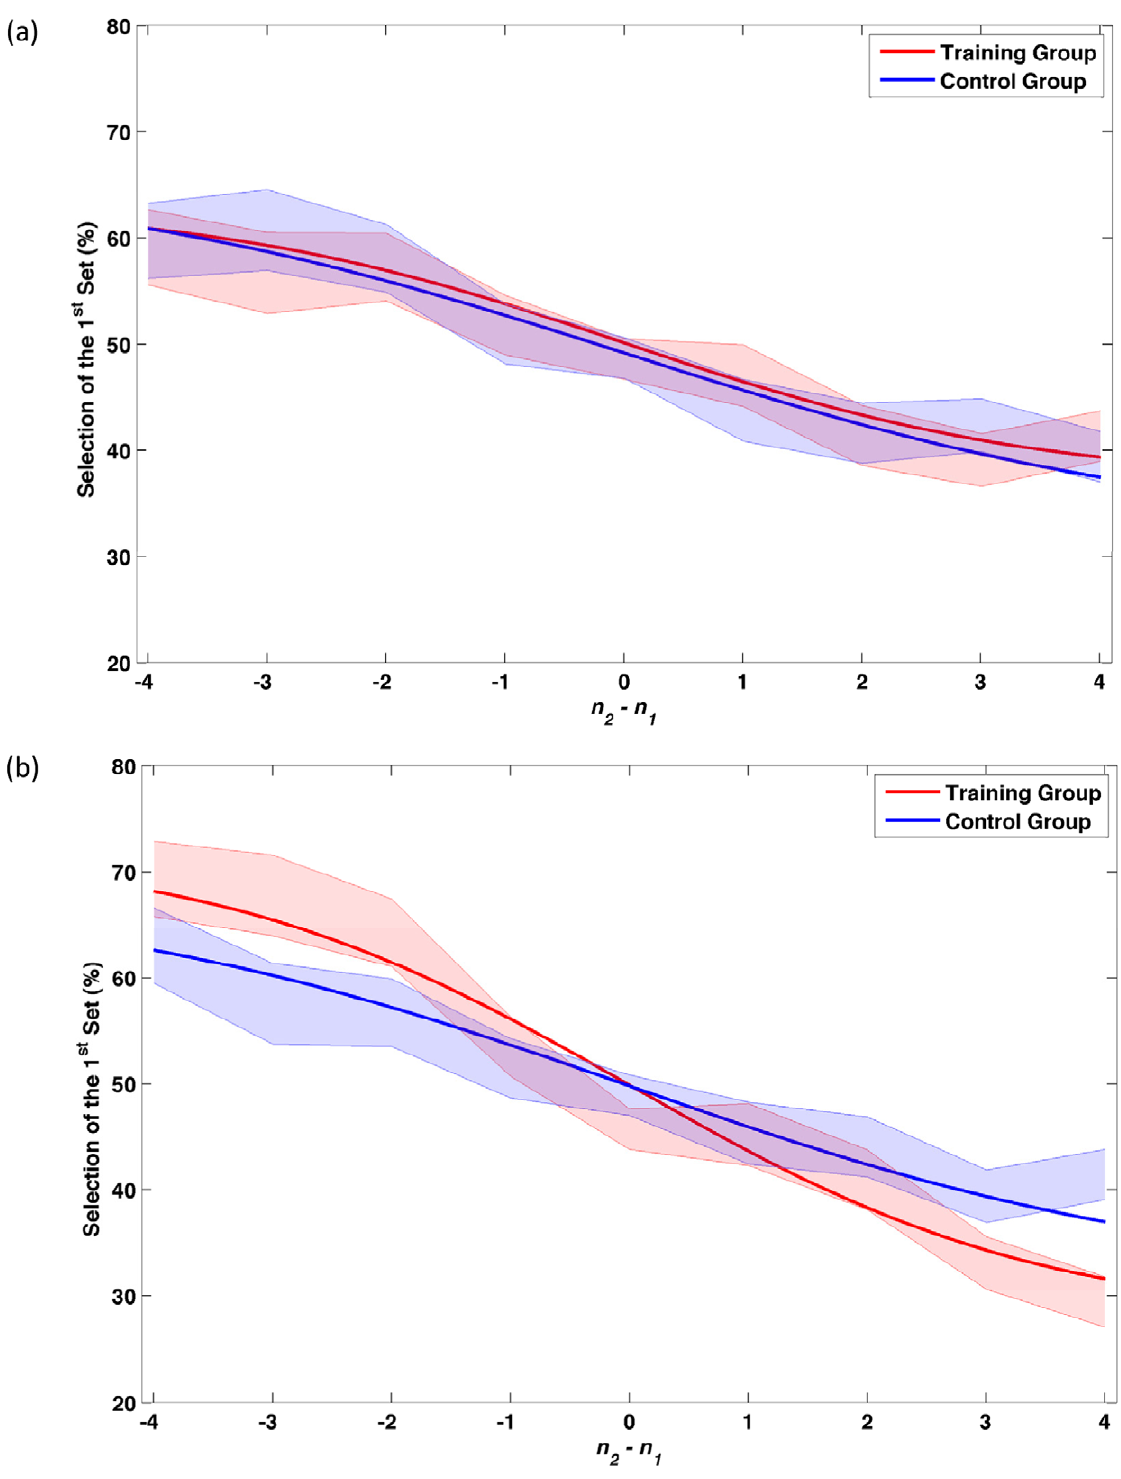
Figure 3. Percentage of selection of the 1 st set for phantom trials ( n 1 ? n 2 and t 1 = t 2 ). (a) 1 st testing session, (b) 2 nd testing session. The shaded areas represent one SD around the mean.